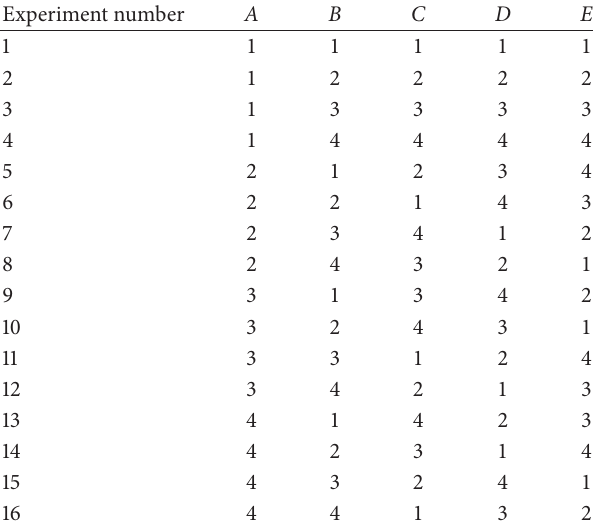
(4 5 ) Taguchi design. 16